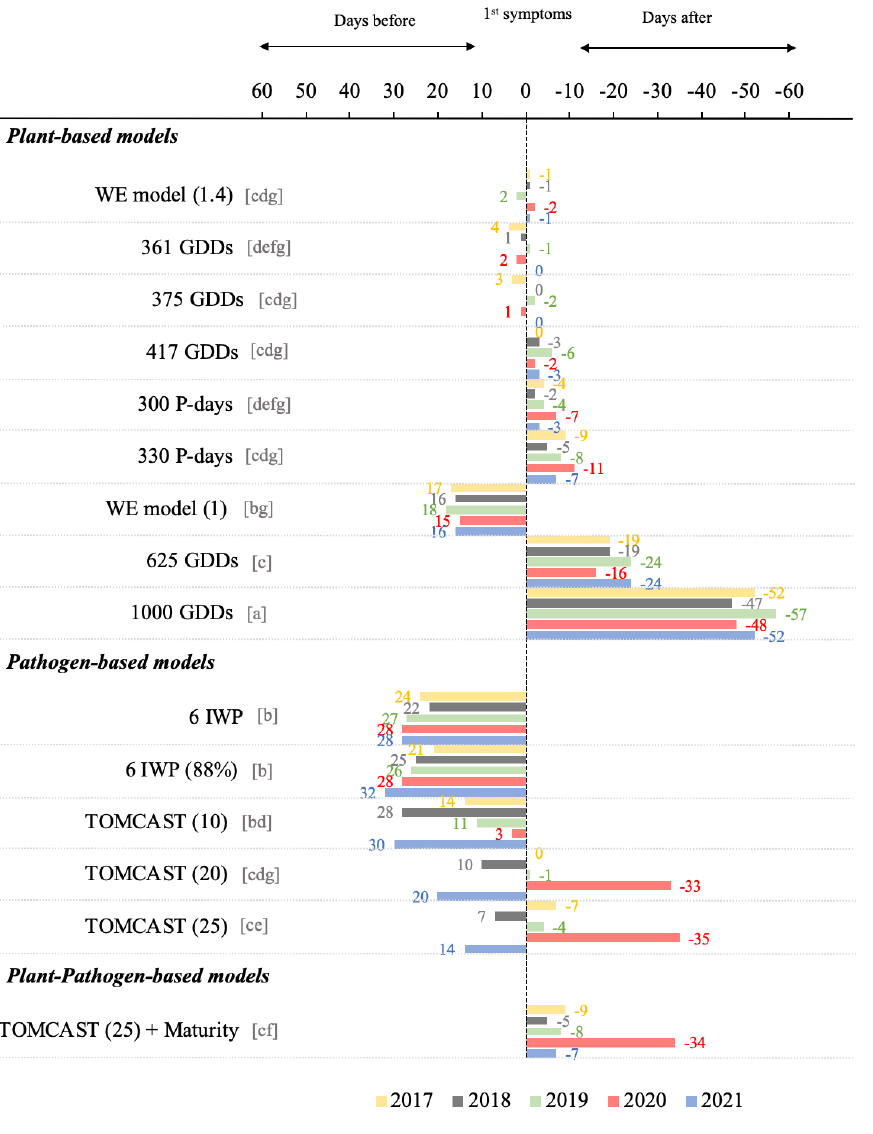
Figure 2. Differences (in days) between risk predicted and observed first early blight symptoms of the tested models in each growing season. Results of Bonferroni test are showed in grey brackets and different letters indicate significant differences between the models ( p < 0.05).